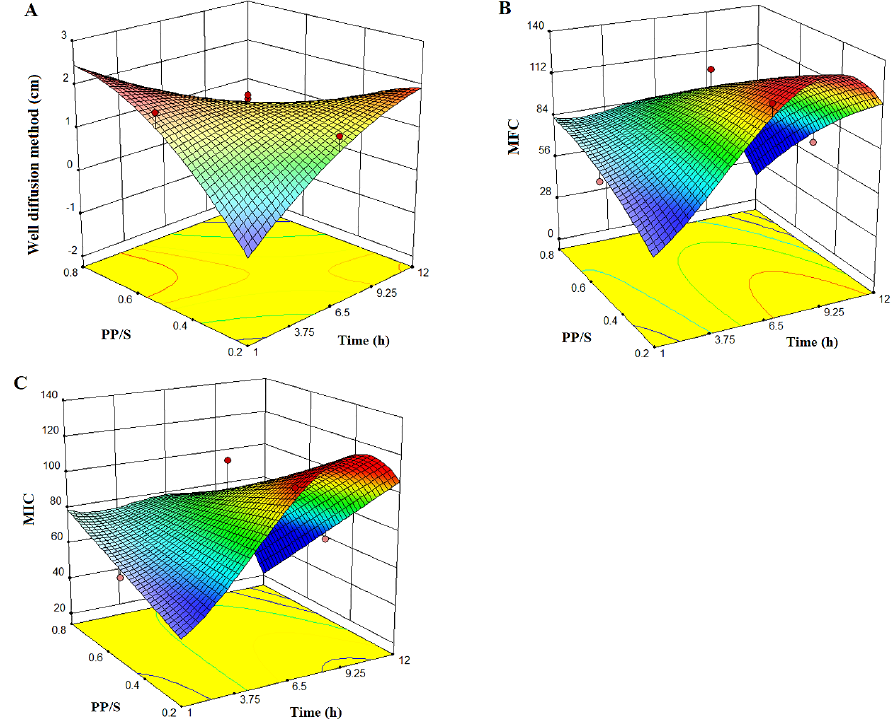
Figure 4. Response surface of the size of the WDM (A), MFC (B) and MIC (C) as a function of time and PP/S at the temperature of 60°C. Note . WDM, well diffusion method; MFC, minimum fungicidal concentration; MIC, minimum inhibitory